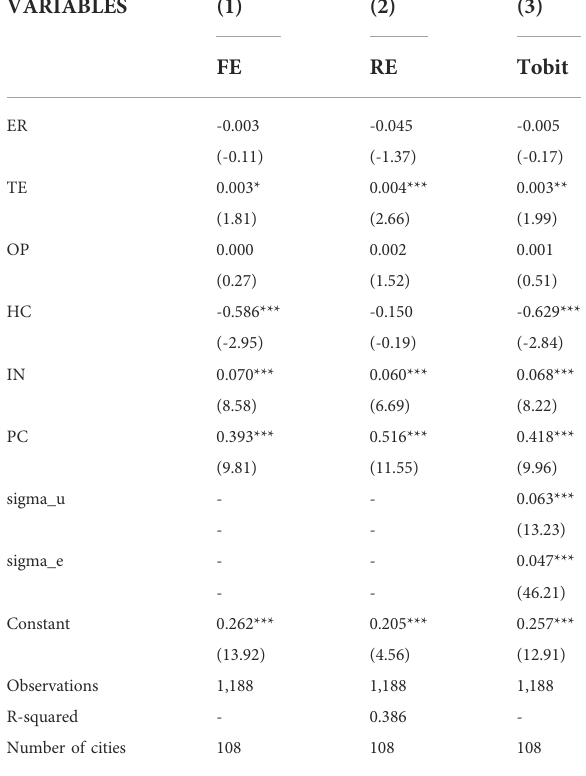
TABLE 4 The regression results for each factor on the degree of coupling coordination between USFD and green economic development in